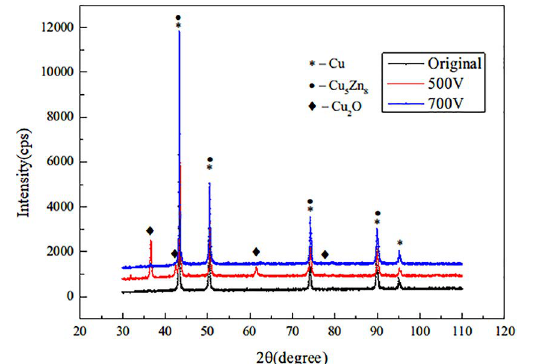
Figure 9. The XRD analysis of the phase structure of samples with corrosion